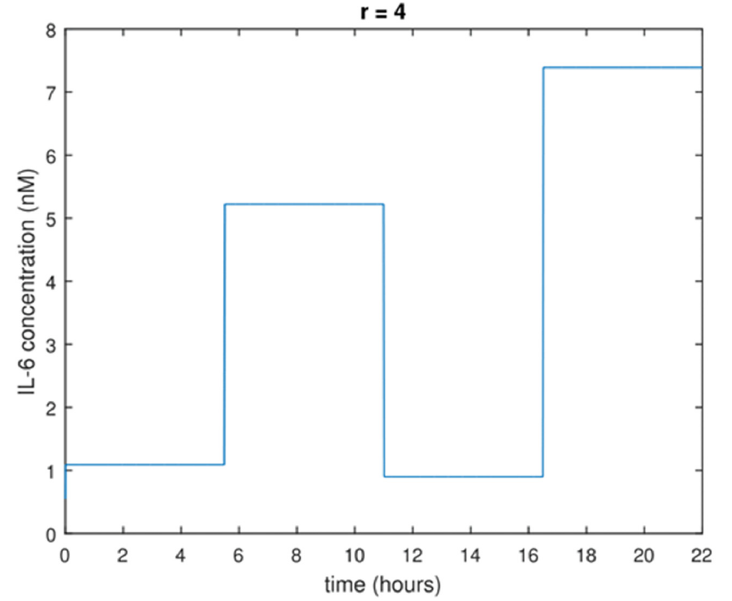
Figure 1. Example of a piecewise constant input function for IL ‐ 6 (Interleukin ‐ 6) concentration with r = 4. The input function shown here can be represented as a vector of the four concentration levels in chronological order: c = [1.1, 5.2, 0.9, 7.4] nM IL ‐ 6.